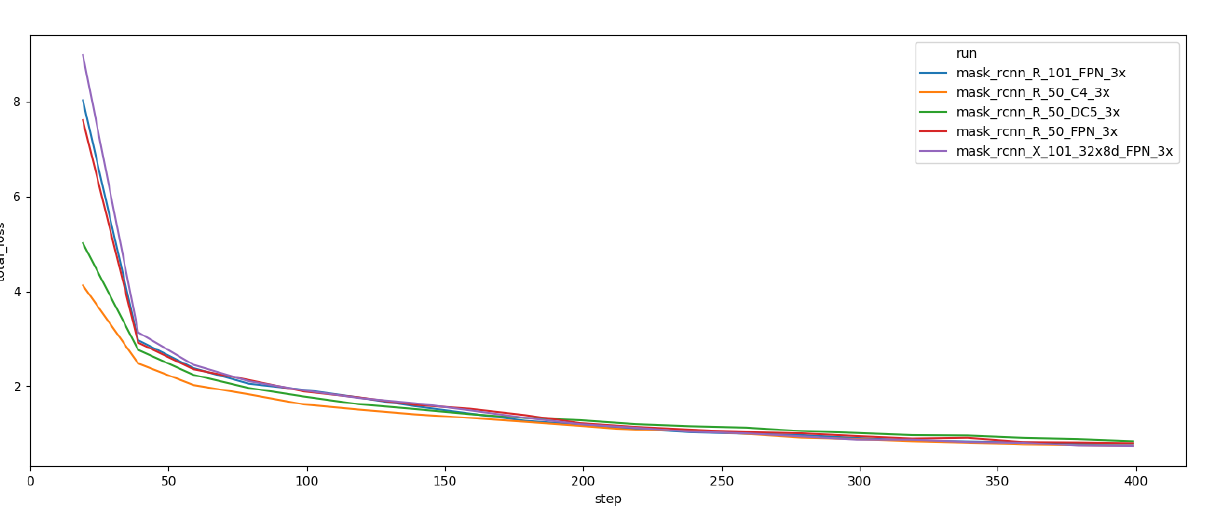
Figure 12. Accuracy rate. Figures 13 and 14 show the result for bounding-box prediction and object segmenta- tion, respectively. The numbers in the figures indicate the confidence for hole classifica- tion.